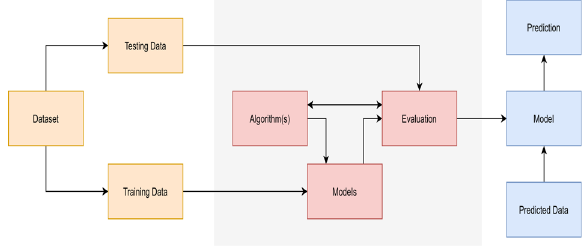
Figure 4. overall view of the proposed research